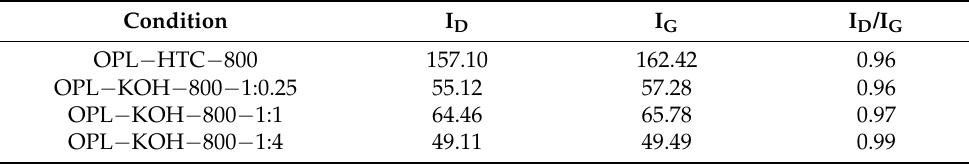
Table 4. Raman spectra of OPL via hydrothermal carbonization and KOH activation.